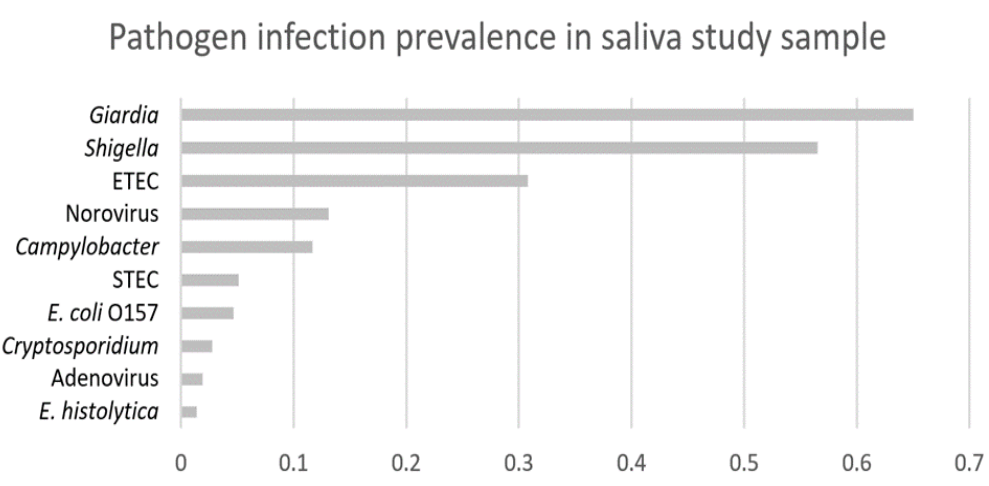
Figure A1. Prevalence of specific pathogens detected in stool samples in the MapSan saliva study sub- study sample.